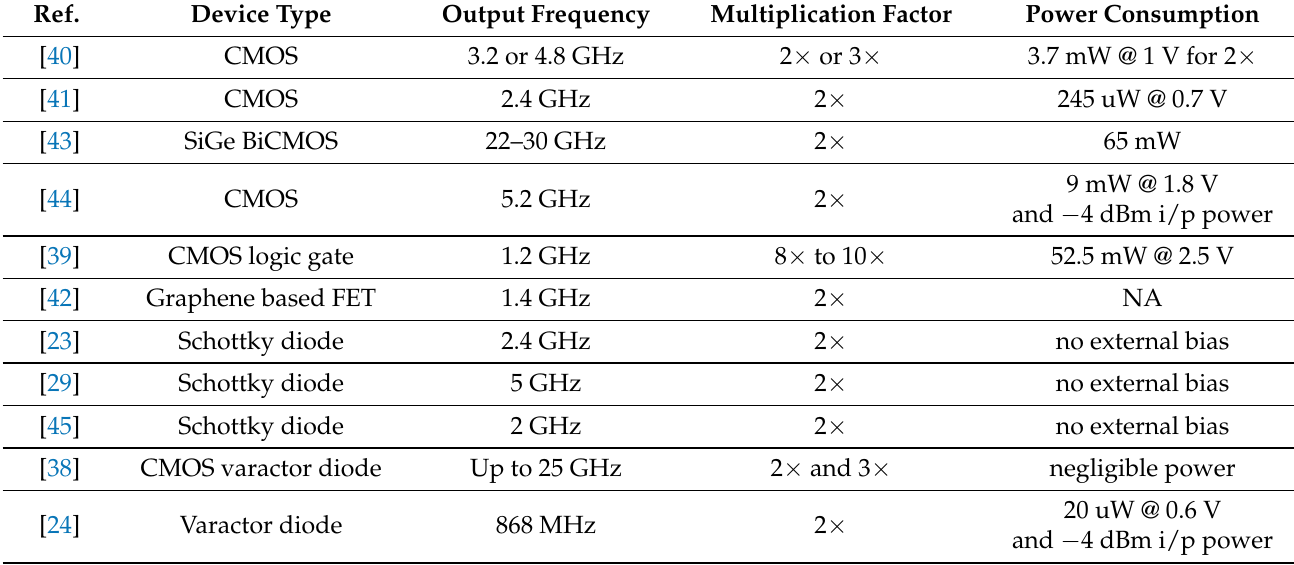
Table 1. Frequency multiplication